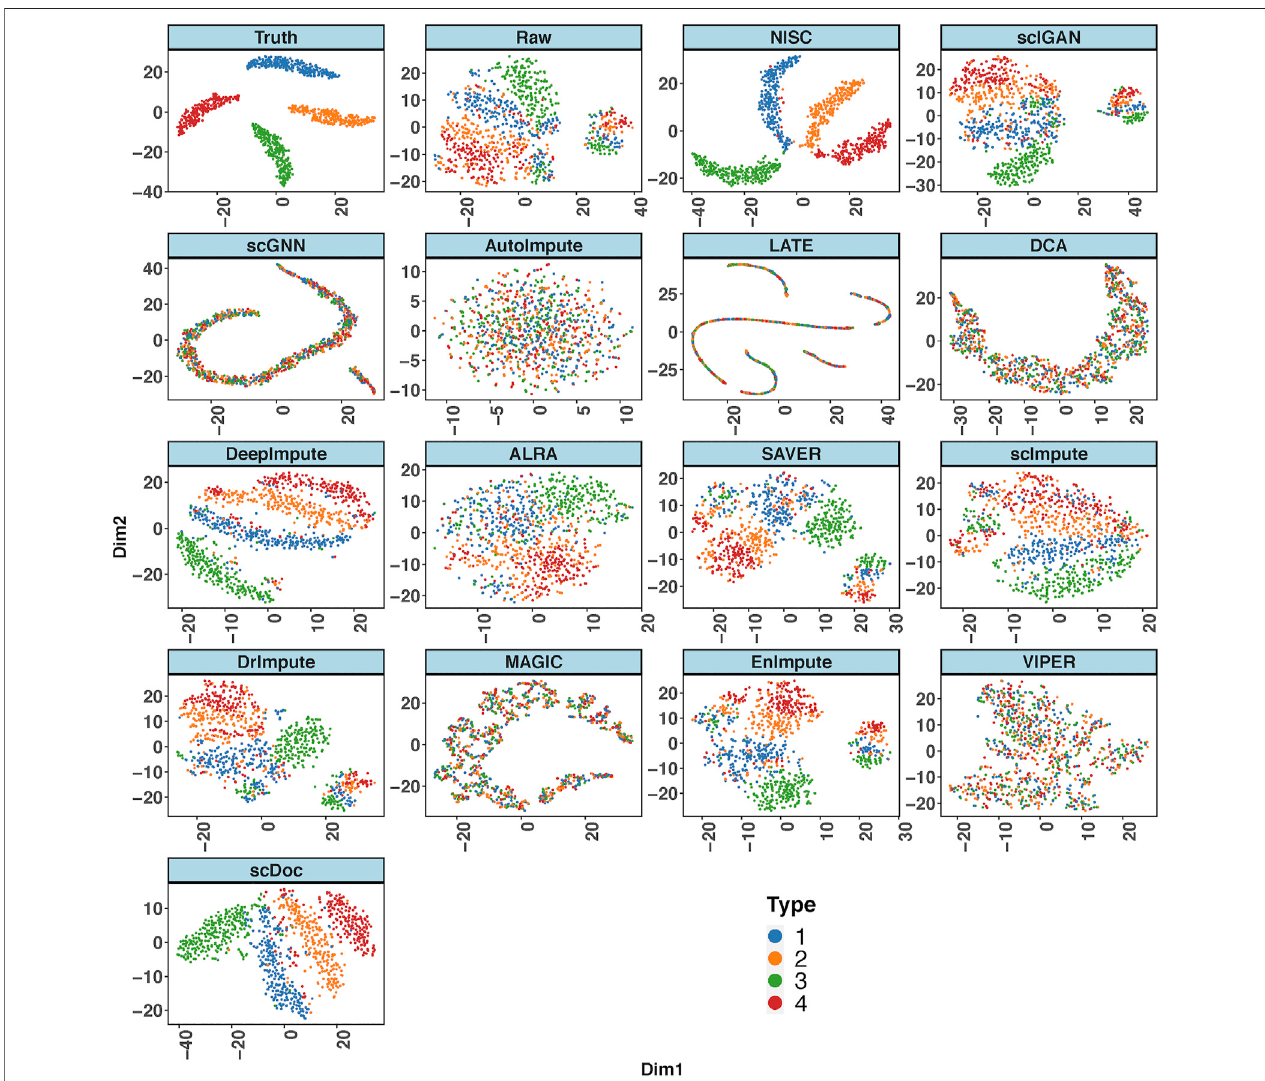
FIGURE 2| NISC signi fi cantly improves the performance of t-SNE in visualizing simulated scRNA-seq count data. Plots of the fi rst two components are calculated fromthesimulatedgroundtruthdata,rawdata,andimputeddatausingvariousimputationmethods.Thedatasetcontains800genesand1,000cellsin4 celltypes,with 90% sparsity. Cells are colored by cell types as